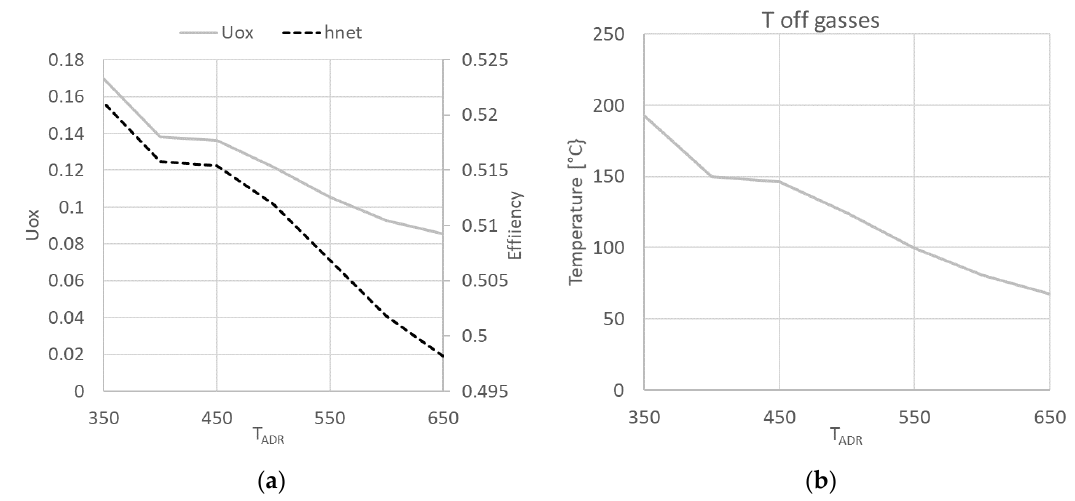
Figure 8. Variation of Uox and η net ( a ) and of off-gases temperature ( b ) as function of T ADR.